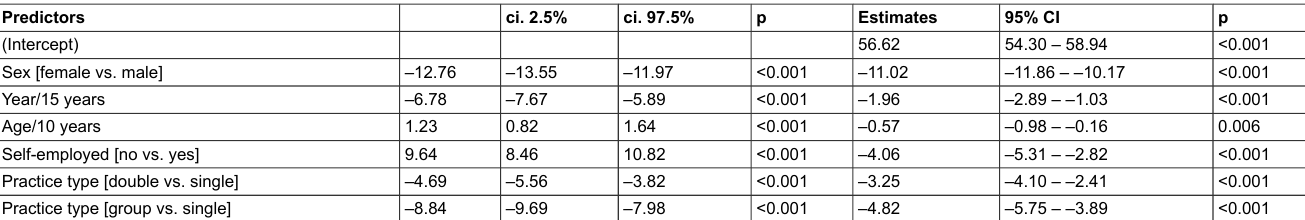
Table 4: Multivariable linear regression analysis to test the association of sex, year, age, employment and practice type with total weekly workload (outcome).